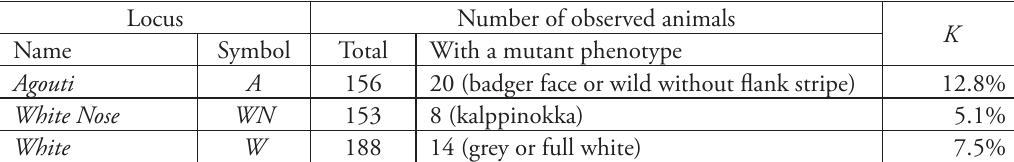
Table 4. Coefficients K of phenotypic coat colour polymorphism at various coat colour loci in the Ahven- järvi sample.